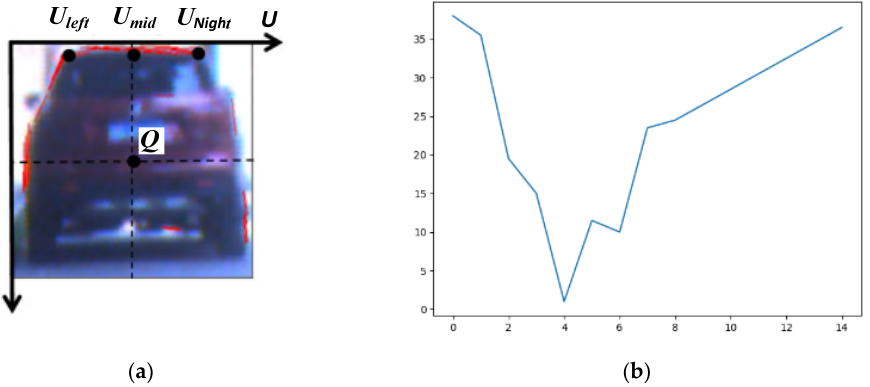
Figure 13. Vehicle symmetry analysis. ( a ) Schematic diagram of symmetry analysis. ( b ) Sliding window symmetry curve.